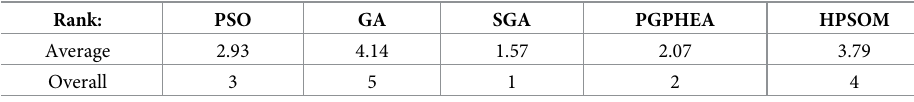
Table 6. Algorithm Ranking for continuous problems of Set